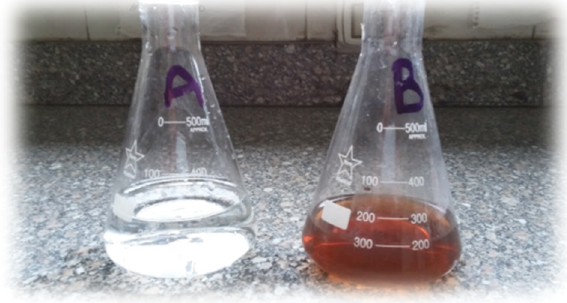
Figure 1: ( A ) Extract of Ulva lactuca and ( B ) biosynthesized silver nanoparticles using U. lactuca